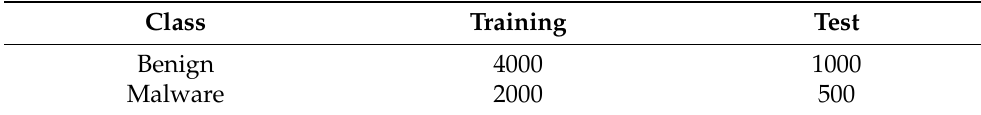
Table 2. Distribution of attributes of datasets used in the